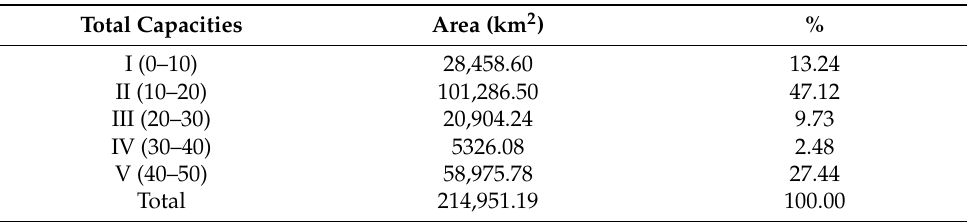
Table 3. Areas and proportions of different levels of total regulating services.